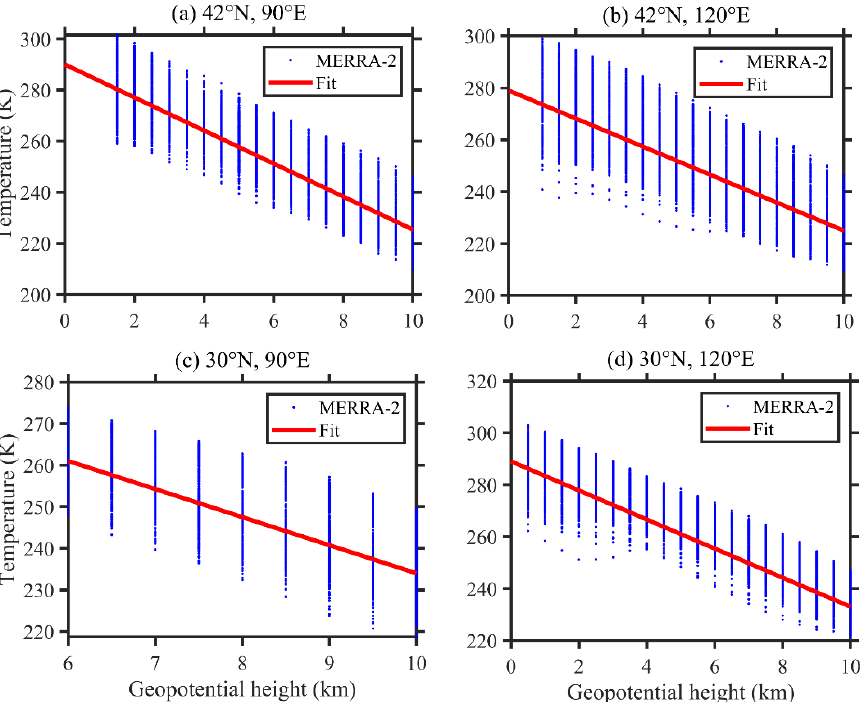
Figure 2. Relationships between temperature and geopotential height at four MERRA-2 grid points over China in 2016: ( a ) 42° N, 90° E; ( b ) 42° N, 120° E; ( c ) 30° N, 90° E; ( d ) 30° N, 120° E. Blue dots are the temperature of MERRA-2 in each height, and red lines are the linear fit to them.